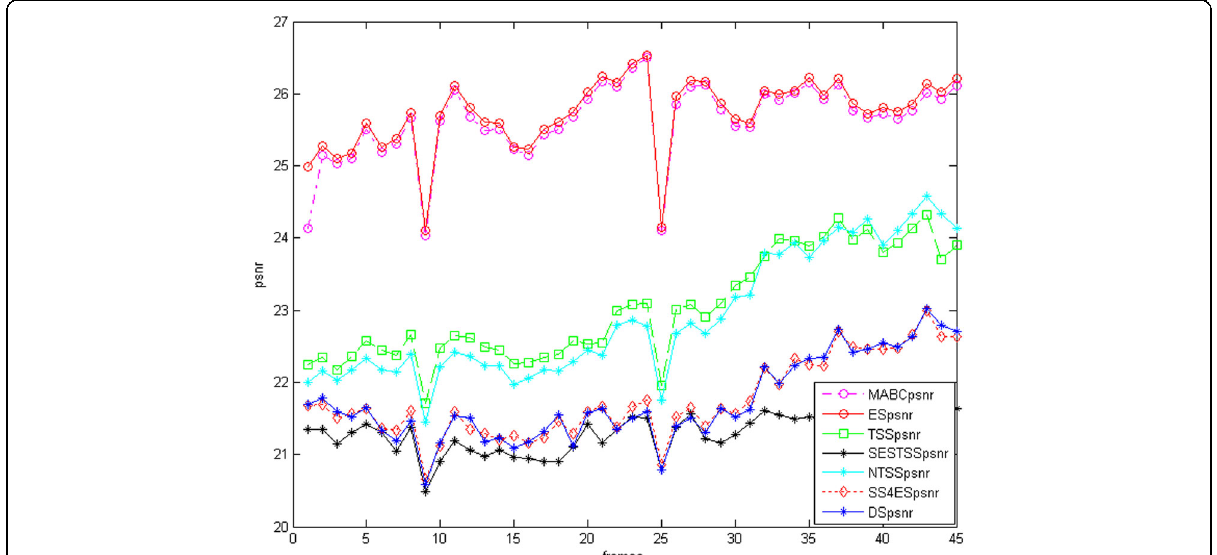
Fig. 5 Comparison of the PSNR values of the 45 frames of “ Bus.cif